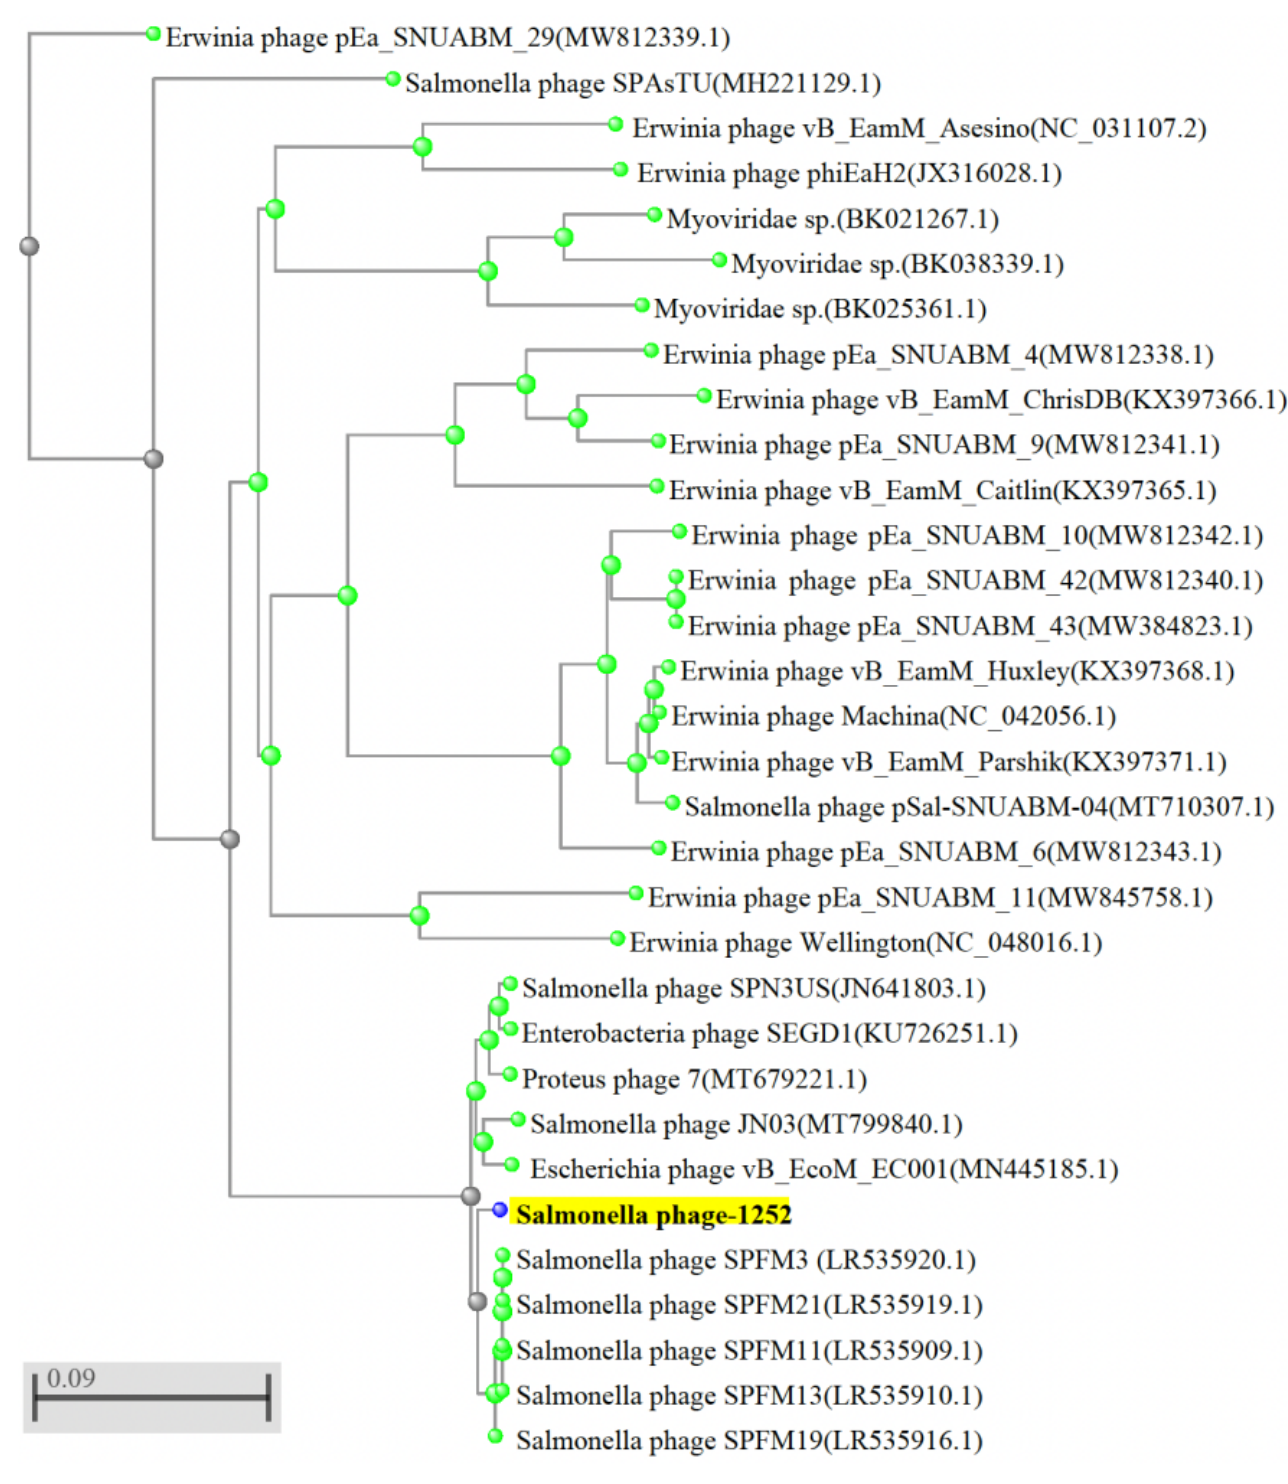
Figure 2. Phylogenetic analysis of Salmonella phage 1252. Phylogenetic tree generated by NCBI- BLAST using the complete genome sequence. Salmonella phage 1252, indicated with a red arrow, shows similarities in topology with other annotated Salmonella